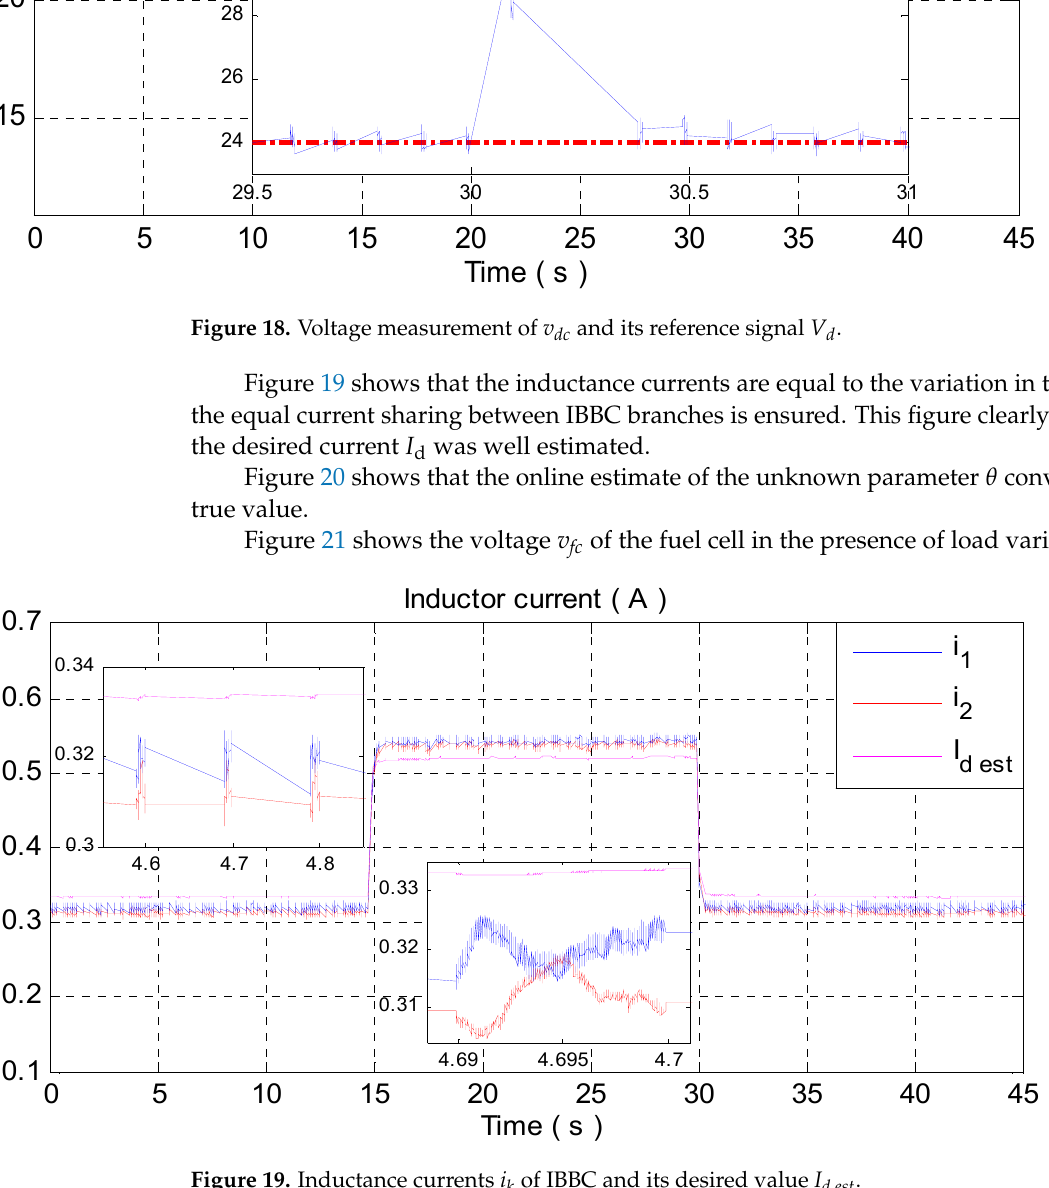
Figure 20. Estimate unknown parameter θ and its reference. Figure 21. Fuel cell voltage v fc .